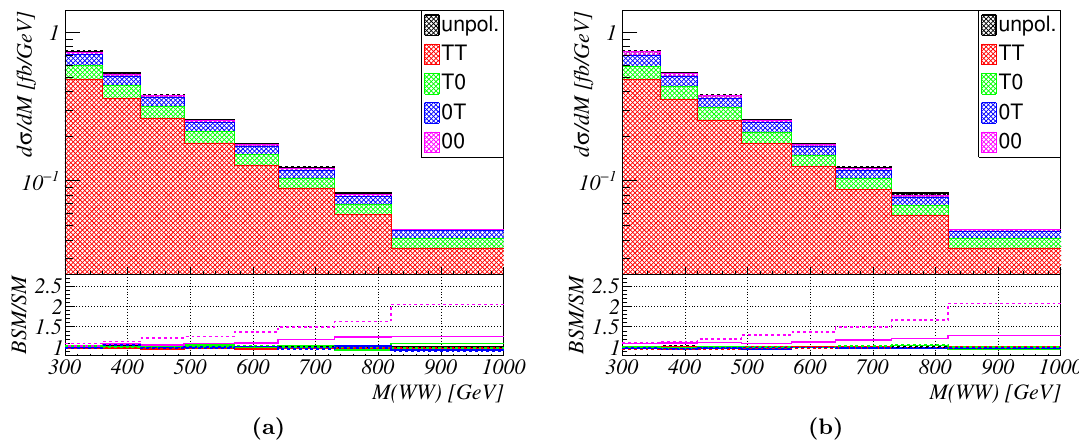
Figure 1. The WW invariant mass spectrum ( d(cid:27)=dM ) for the unpolarized, EW process pp ! jjW + W (cid:0) at LO, in the SM limit ( a = 1 : 0). The lower panel shows the ratio R [ M ( WW )] eq. (4.6) of (cid:21) (cid:21) 0 the Composite Higgs scenarios with a = 0 : 8 (dashed line) and a = 0 : 9 (solid line). The polarization ( (cid:21); (cid:21) 0 ) is de(cid:12)ned in the (a) parton c.m. frame and (b) WW c.m. frame. Due to rounding errors, the sum of f obfuscates that the sum of the polarization (cid:21)(cid:21) 0 con(cid:12)gurations reproduces the unpolarized rate. Satisfying closure requirements in 2 !